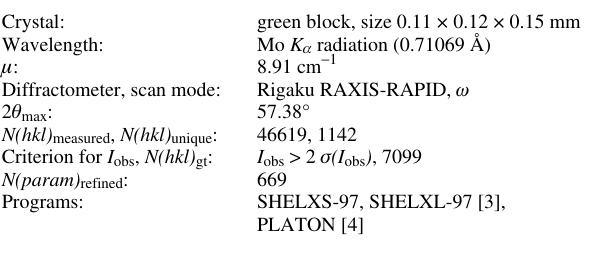
Table 1. Data collection and handling.